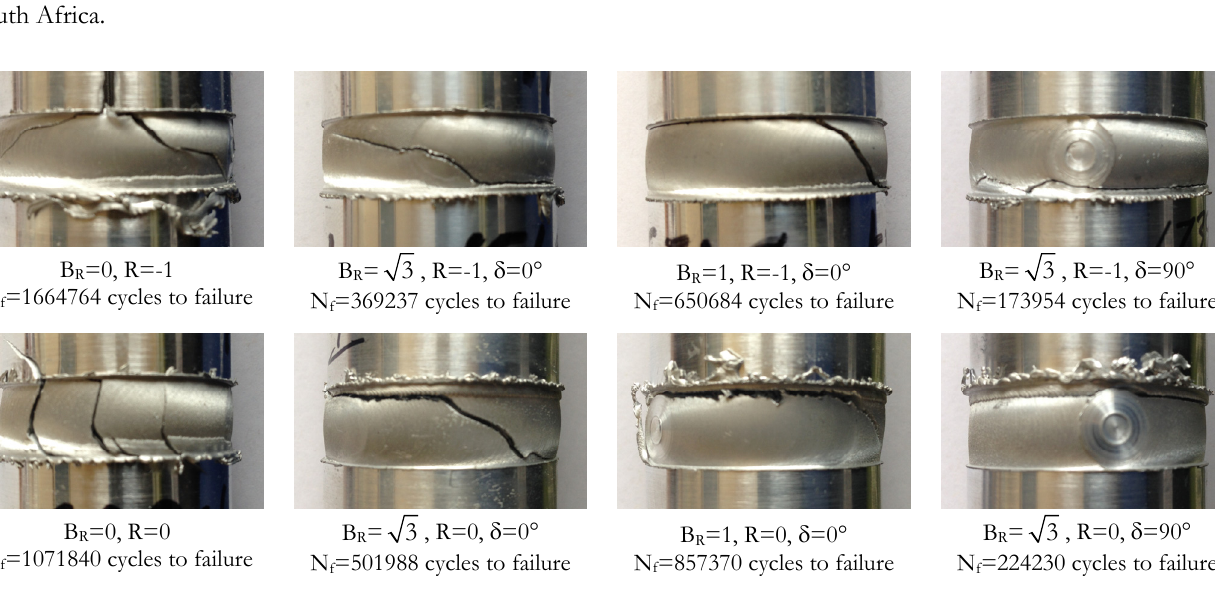
Figure 4: Examples of the observed macroscopic cracking behavior under biaxial fatigue loading (B R =  nom,a /  nom,a , R=  nom,min /  nom,max =  nom,min /  nom,max ,  = out-of-phase